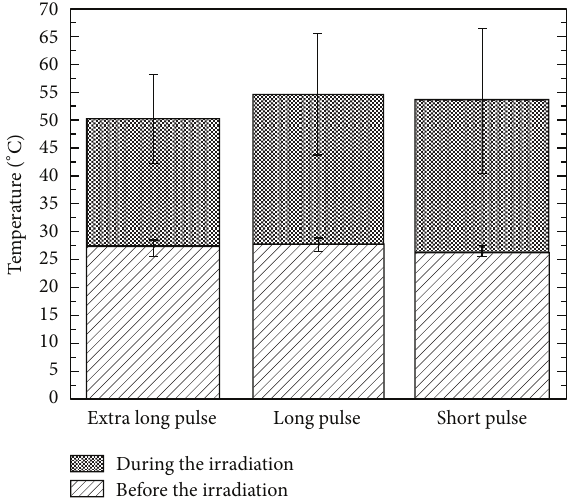
Figure 2: Initial temperature analyzed before irradiation and thermal changes ( ∘ C) measured at specimens of primary enamel during the Nd:YAG laser